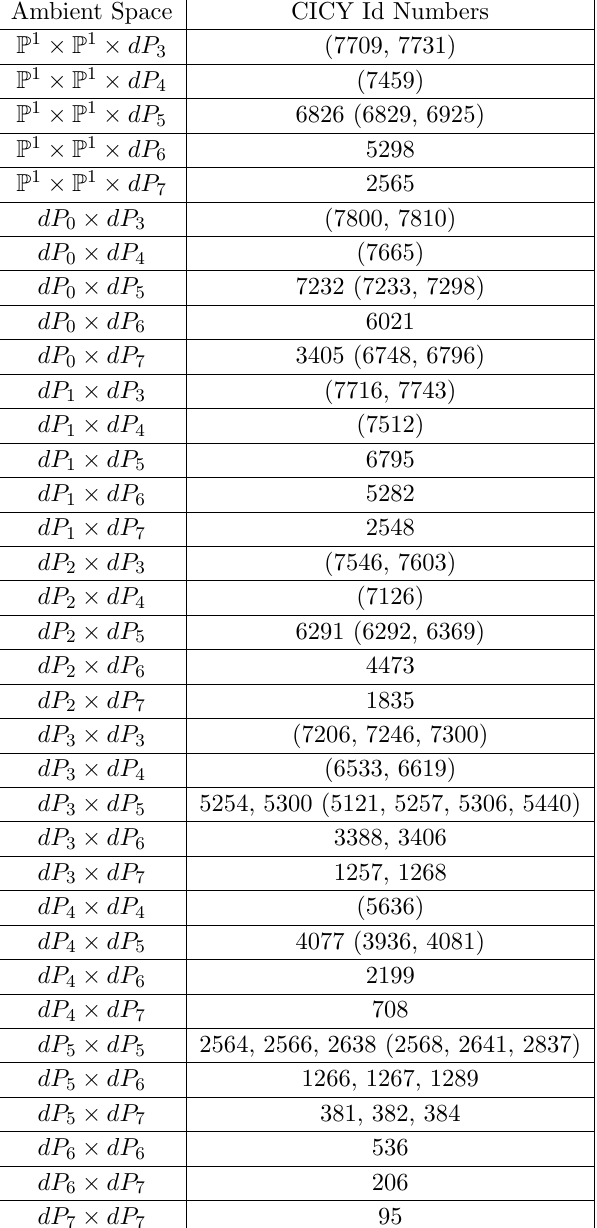
Table 1 . The 33 exceptional con(cid:12)gurations which are not favorable with respect to the ambient product of projective spaces and which are not the Schoen manifold. Each of them turns out to be an anticanonical divisor of either dP r (cid:2) dP s or P 1 (cid:2) P 1 (cid:2) dP s , for r = 0 ; (cid:1) (cid:1) (cid:1) ; 7 and s = 5 ; 6 ; 7. The con(cid:12)gurations are labelled by their standard CICY ID numbers [3, 16]. In fact, there exist an additional 35 con(cid:12)gurations which describe an anticanonical divisor in ambient spaces of the same form with possibly some smaller values of s . These are favorable but not K(cid:127)ahler-favorable with respect to the ambient product of projective spaces, and are also listed here in parentheses.